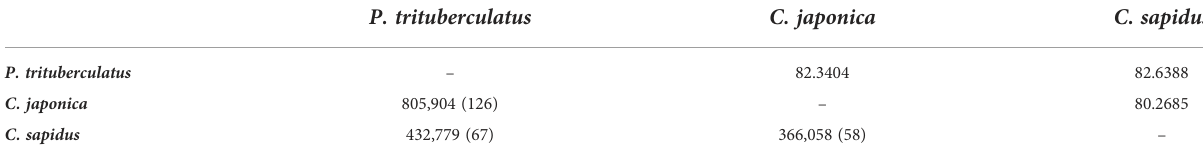
TABLE 4 Pairwise results of Mummer (lower diagonal) and Average Nucleotide Identity (upper diagonal) among three crab